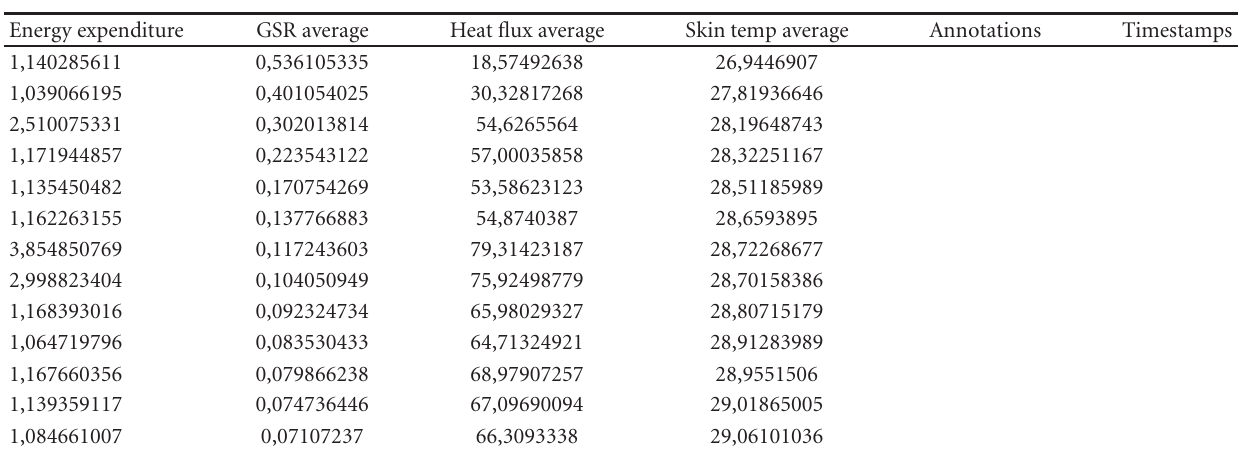
2009-09-01 13:53:00,000 0 (b) Extract of the timestamped pre-processed sensor data for subject 3 (columns 9–14). Energy expenditure GSR average Heat flux average Skin temp